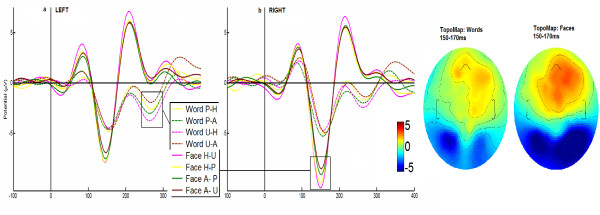
N170 waveform and topography. N170 component elicited by emotional words and faces. The N170 modulation is predominant in the left hemisphere for words and in the right for faces. Boxes in ERPs figures are indicative of regions where statistical comparison shown significant differences. Right side of the figure: Word and Face voltage maps averaged on 140-190 ms. Abbreviations: Word P-A (pleasant words associated to anger face); Word U-A (unpleasant words associated to anger face); Face H-P (happy faces associated to pleasant word); Face H-U (happy faces associated to unpleasant word); Face A-U (anger faces associated to unpleasant word); Face A-P (anger faces associated to pleasant word).